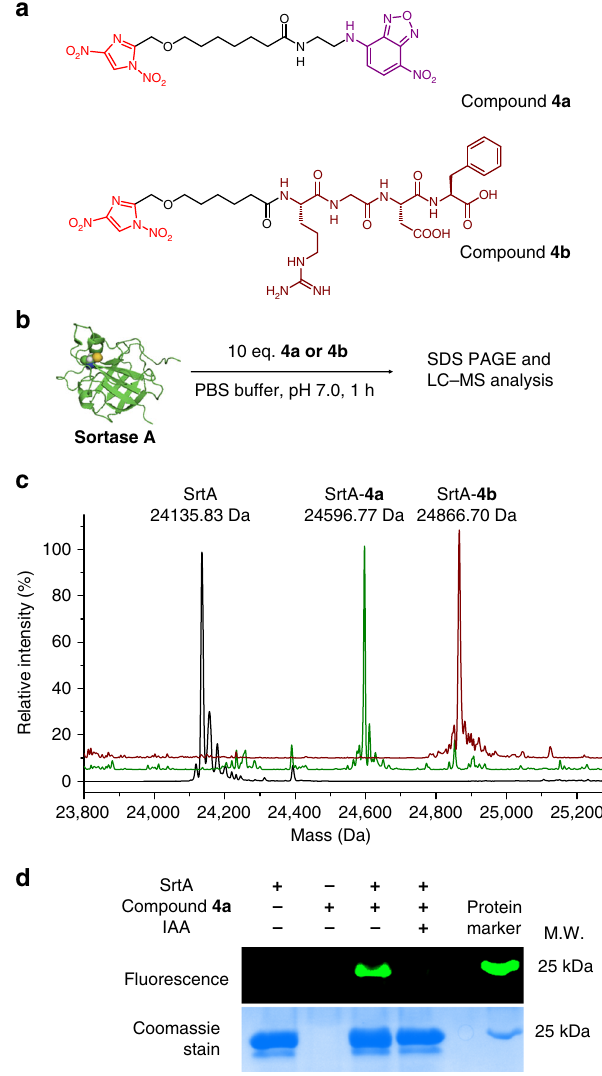
Fig. 3 Modi fi cation of SrtA with 1,4-DNIms bearing a fl uorescent NBD moiety and an RGD peptide. a Chemical structures of 1,4-DNIm derivatives 4a and 4b . b Bioconjugation of SrtA by 1,4-DNIm derivatives.